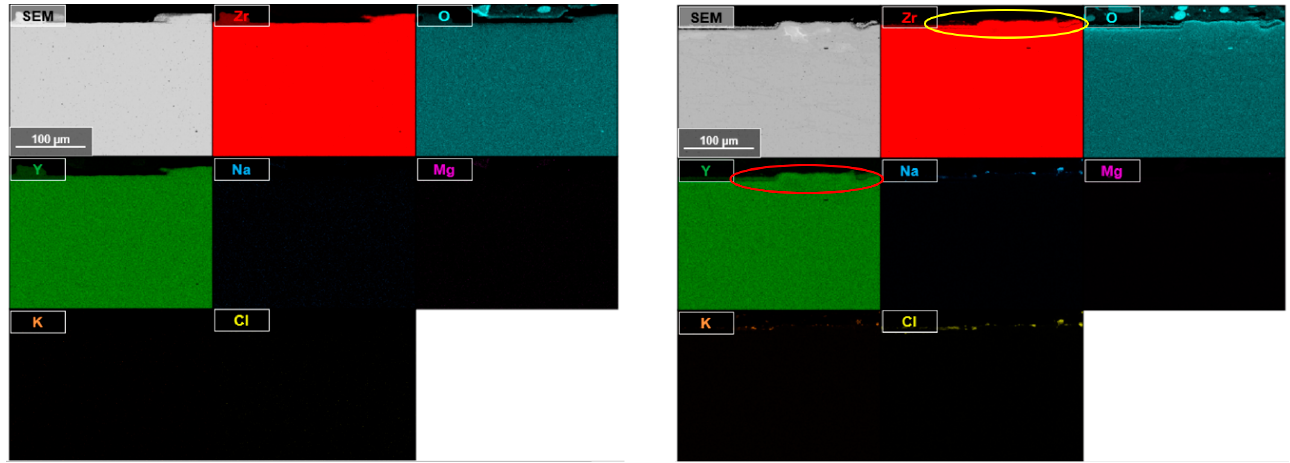
Figure 7. SEM-EDX images of the cross section of ZrO 2 samples before ( left ) and after ( right ) molten salt exposure. After molten salt exposure, the concentrations of the Y and Zr elements on the surface of ZrO 2 sample (in red and yellow circles) were reduced.